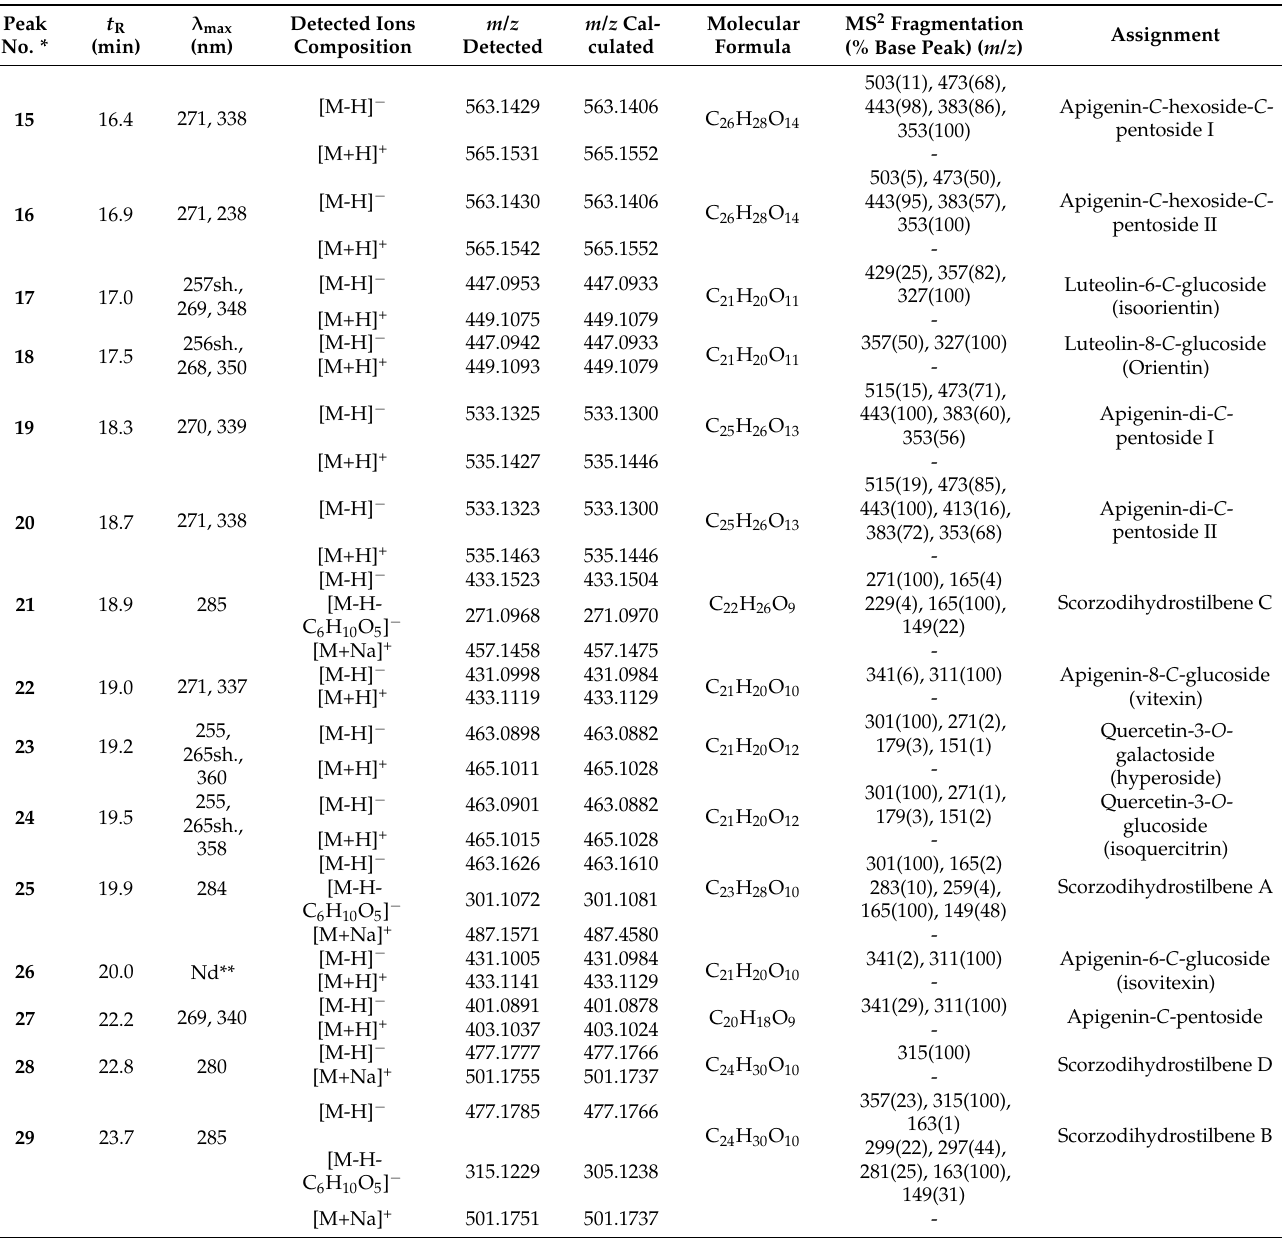
Table 4. List of flavonoid and dihydrostilbene derivatives identified in the methanol extracts of S. radiata leaves by their retention times, UV and MS data, and by comparison with published